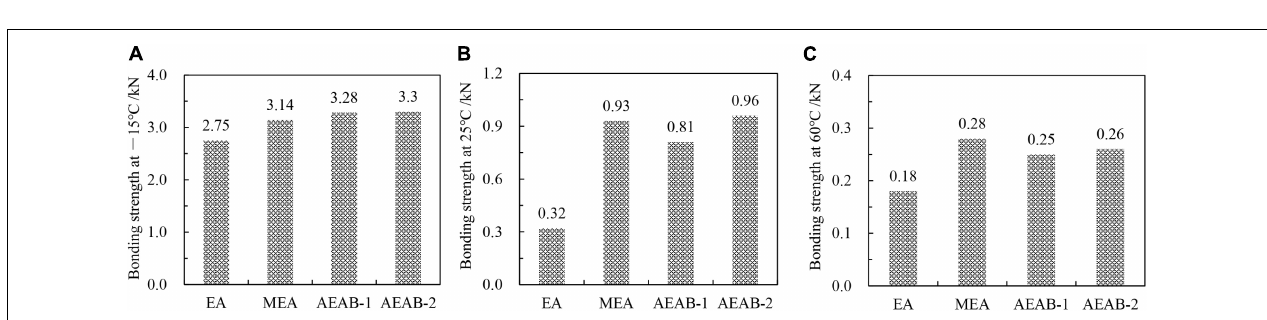
FIGURE 9 | Observation during snowing weather in Harbin China. (A) Snow-melting conditions after light snow in November 2019. (B) Snow-removing conditions after heavy snow in December 2019.